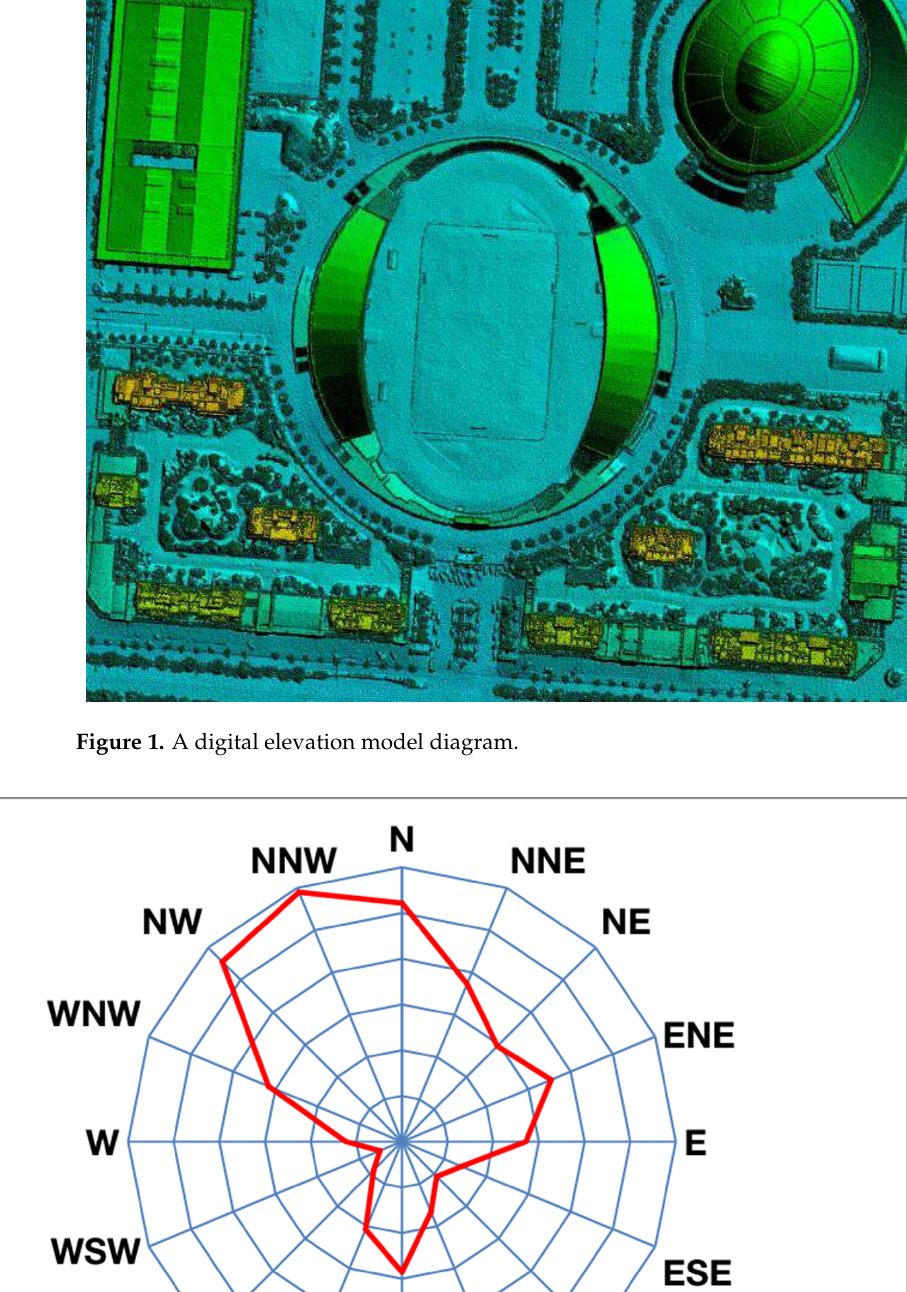
Figure 3. Summer wind rose illustration of Deqing City. In Figure 2, the dominant wind direction in Deqing City during winter is northwest. The frequencies of the NNW, NW, and N wind directions were 11.8%, 11.13%, and 10.43%, respectively, and the sum of the frequencies was 33.36%. In Figure 3, there are two main wind directions: the southerly wind and easterly wind in Deqing City during summer. The frequencies of the SSW and S wind directions were 11.45% and 11.19%, respectively, and the sum of the frequencies was 22.64%. The frequencies of the E, ENE, and ESE wind directions were 8.85%, 8.09%, and 6.48%, respectively, and the sum of the frequencies was 23.42%.